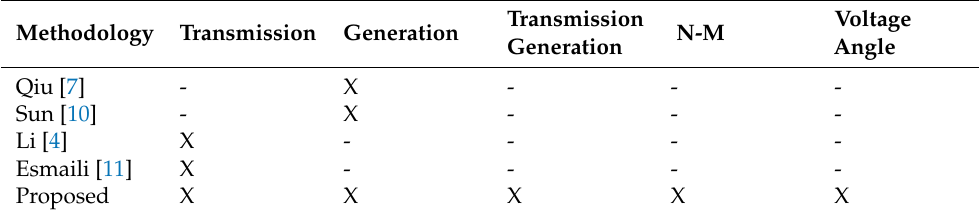
Table 5. Comparison of the proposed